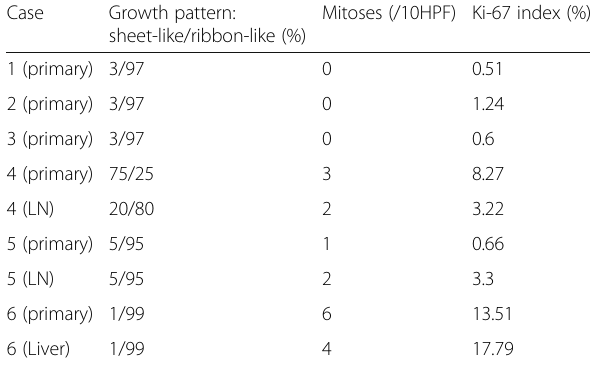
Table 3 Histologic growth pattern, mitosis and Ki-67 morphometric analysis (Automated counting by analyzer)